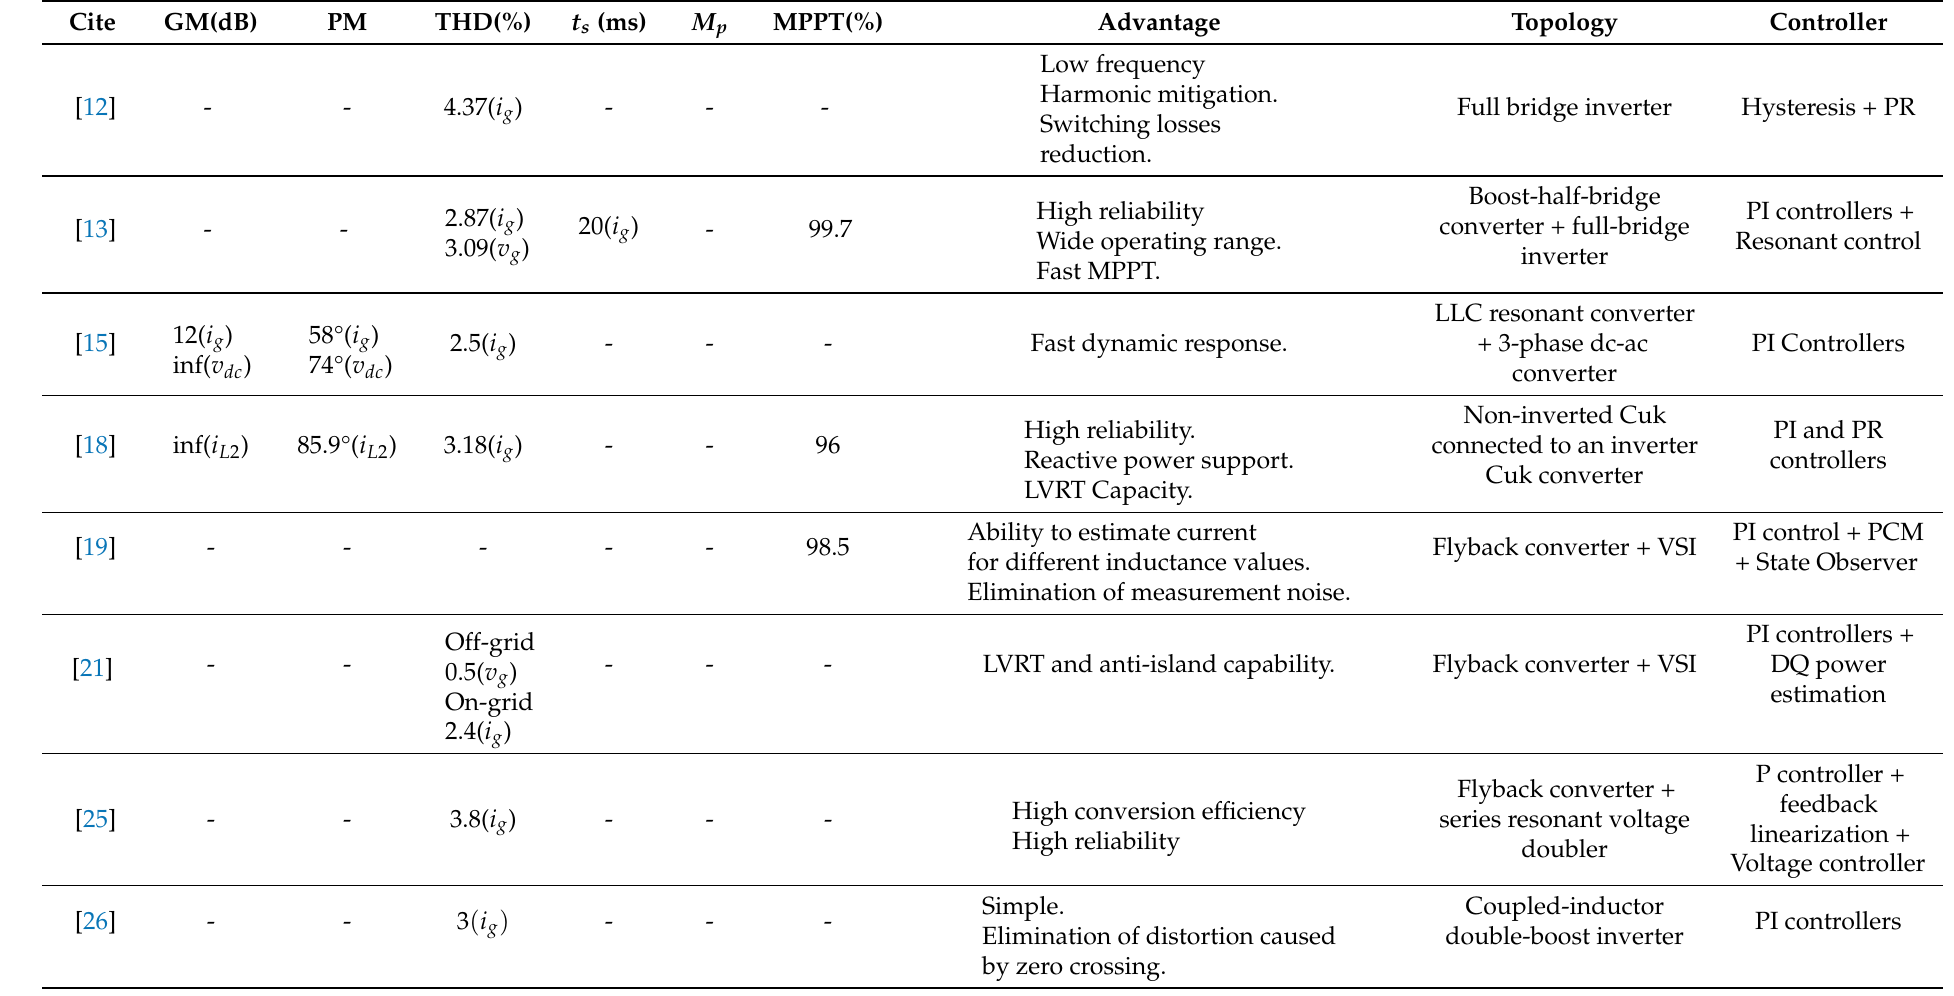
Table 1. Characteristics of the revised control